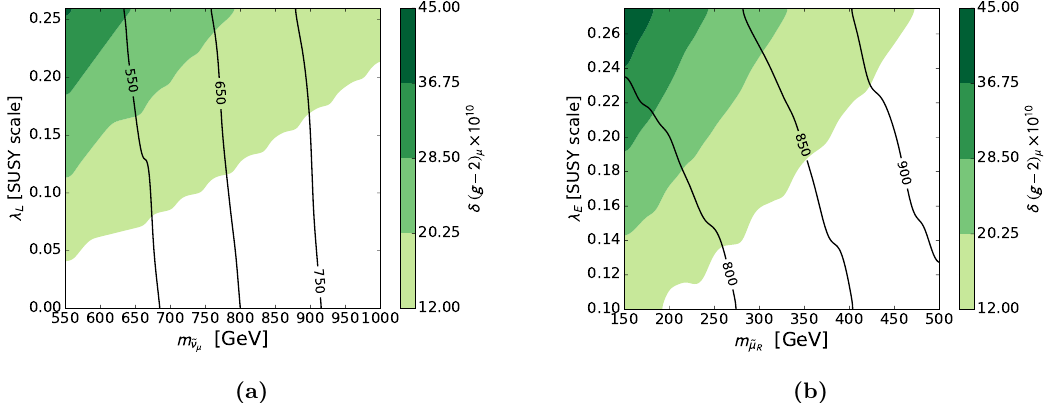
Figure 9. (a) (cid:14) ( g 2) in the LD model as a function of the pole mass of the (cid:12)rst sneutrino (cid:22) (cid:0) eigenstate (a mixed muon sneutrino/VL sneutrino state) and of the Yukawa (cid:21) L at the SUSY scale. The remaining parameters are chosen as in the benchmark point of table 2. Black lines show contours of the lightest slepton mass. (b) (cid:14) ( g 2) in the QUE model as a function of the pole (cid:22) (cid:0) mass of the (cid:12)rst selectron eigenstate (a mixed smuon/ VL slepton state) and of the Yukawa (cid:21) E at the SUSY scale. Black solid lines show contours of the second-lightest slepton